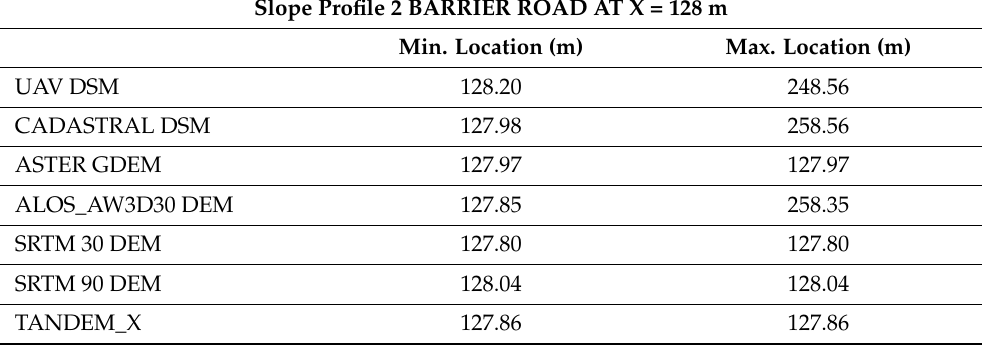
Table 5. Horizontal location of rock end points for the 2nd slope profile.